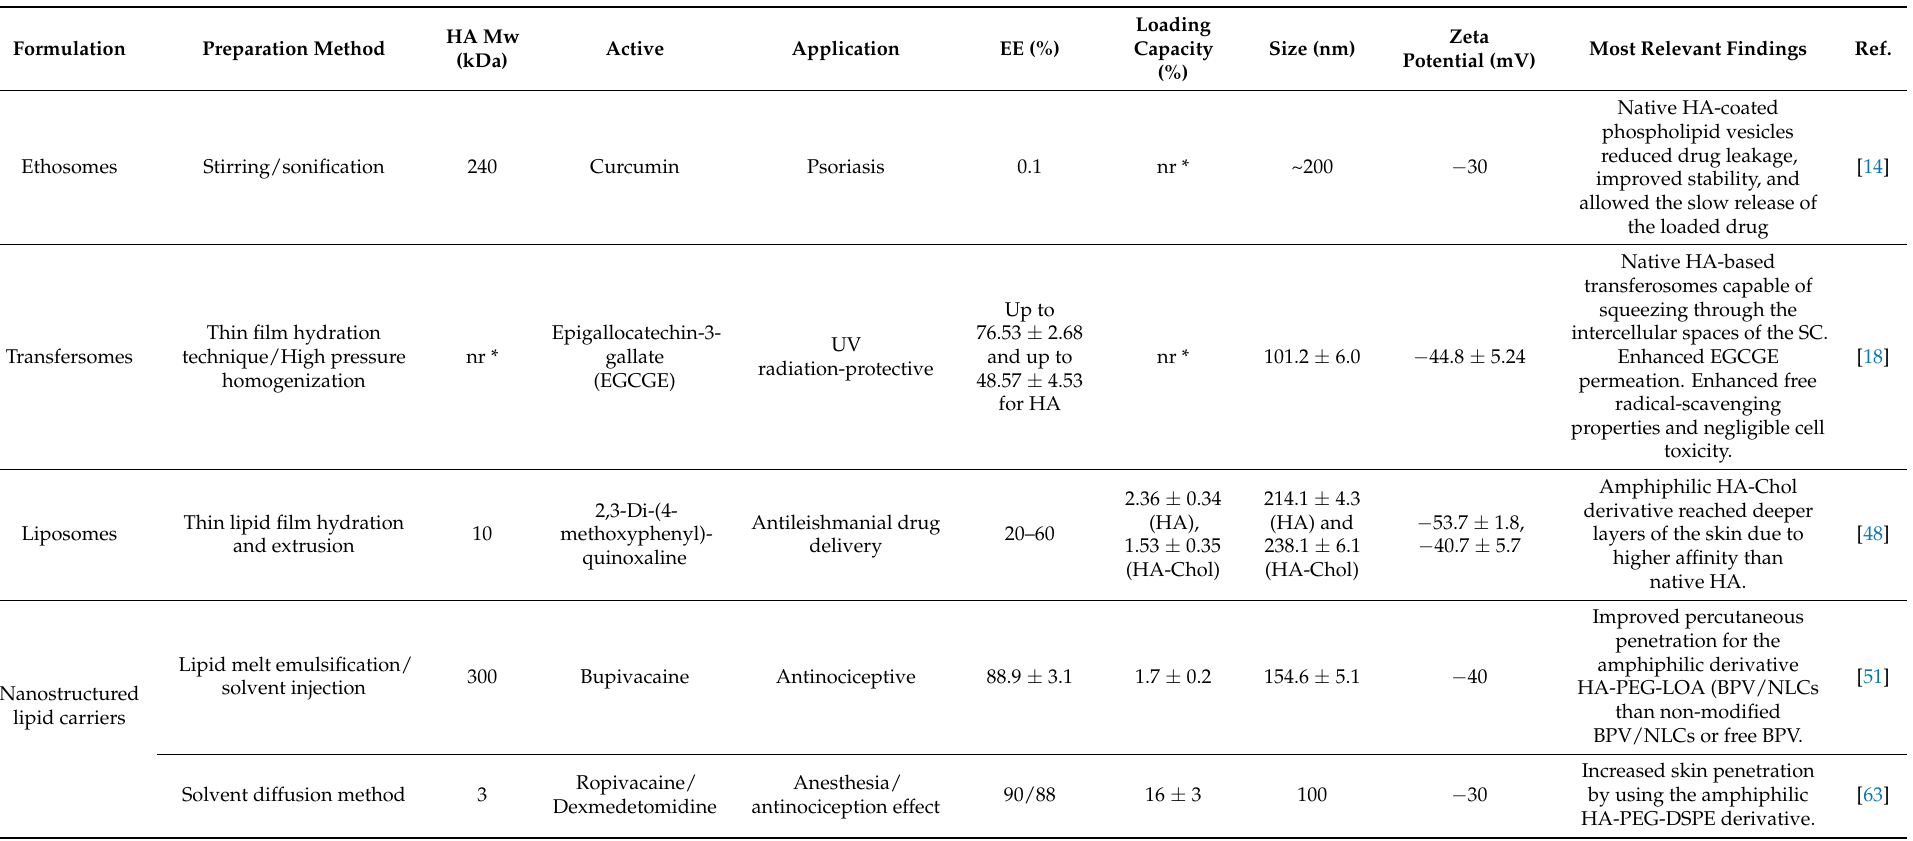
Table 3. Nanoparticulation of HA for topical delivery (nr * means unreported in the corresponding